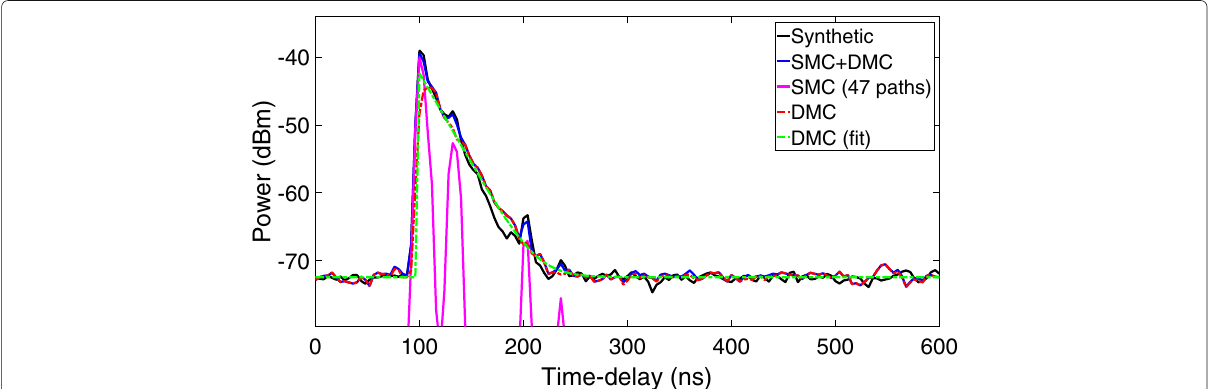
Fig. 3 APDP of the synthetic radio channel in the time-delay domain, together with the UWB-RiMAX retained SMC, the DMC, and noise